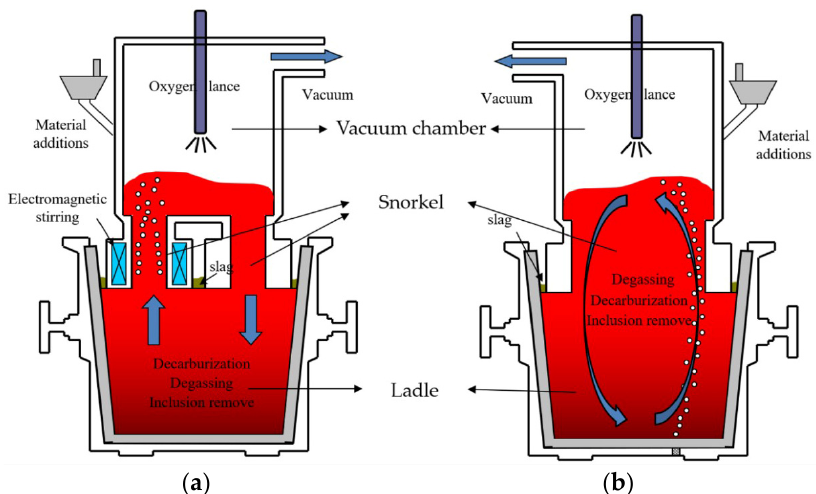
Figure 1. Schematic of two typical vacuum refining furnaces [2]: ( a ) RH; ( b ) SSF.